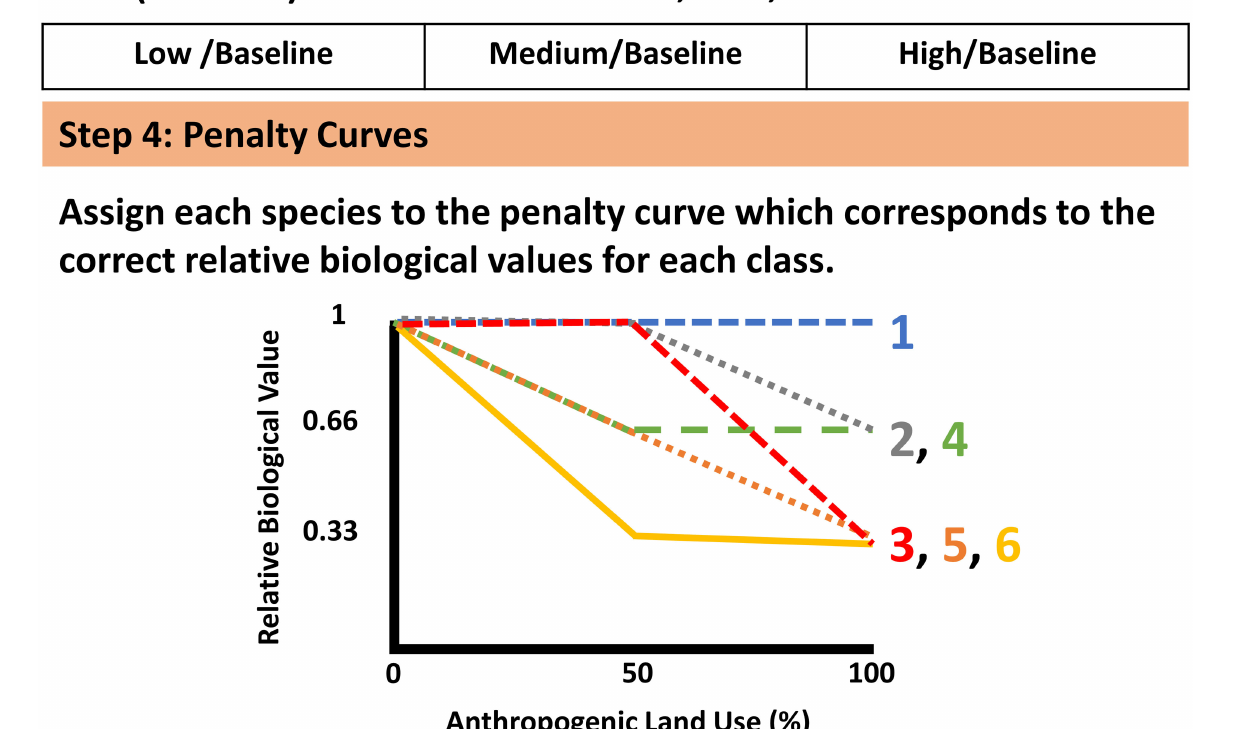
FIGURE 2 | Framework used for developing upstream habitat integrity penalty curves. The penalty curve associated with each species can be found in Appendix 3 in Supplementary Material .